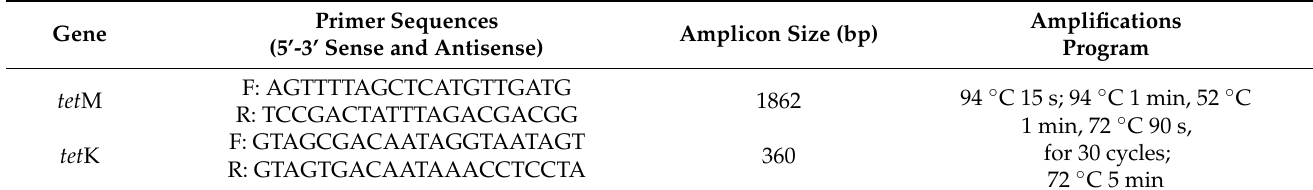
Table 3. Primer sequences, amplicon size and amplicon program of tet M and tet K genes.